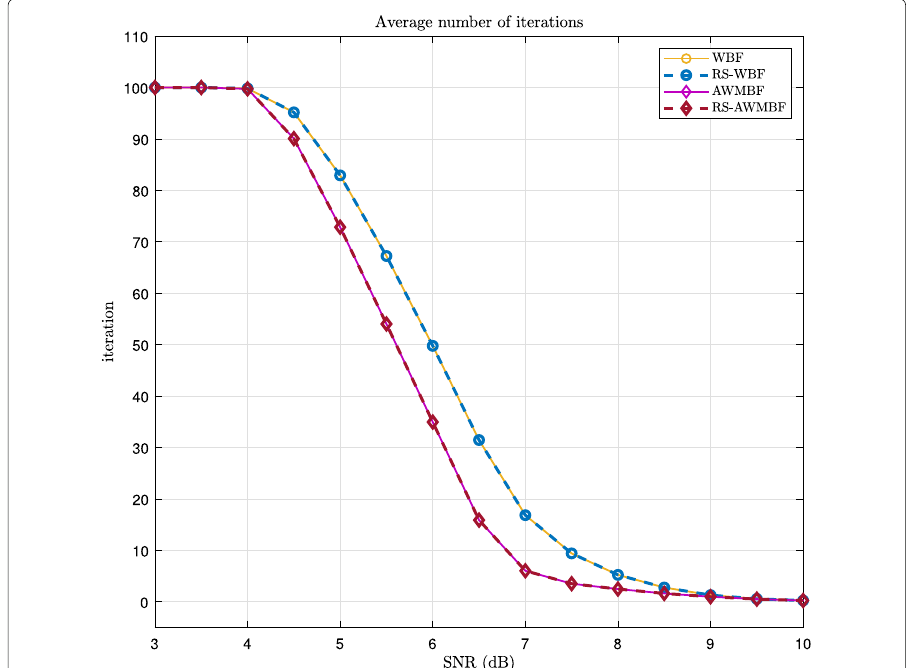
Fig. 5 Number of iterations versus SNR for the (4,32)-regular LDPC code with N = 8176